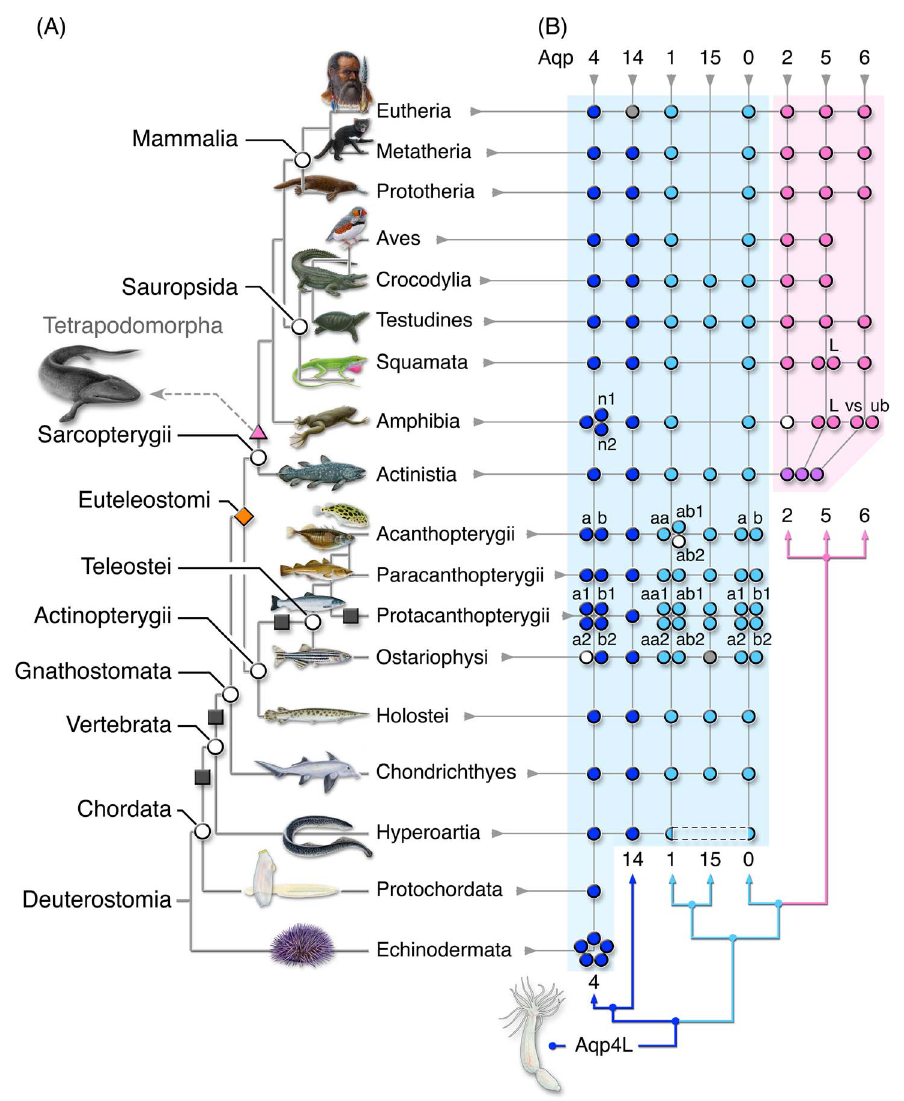
Figure 4. Evolutionary Distribution of Deuterostome Classical Aquaporins. (A ) Phylogenetic relationships of the major deuterostome groups studied. ( B ) Prevalence of classical aquaporin genes identified in each lineage showing postscript nomenclature for duplicated forms. Coloured dots are specific for the species shown, white dots are found in the same lineage, but a different species, while grey dots indicate